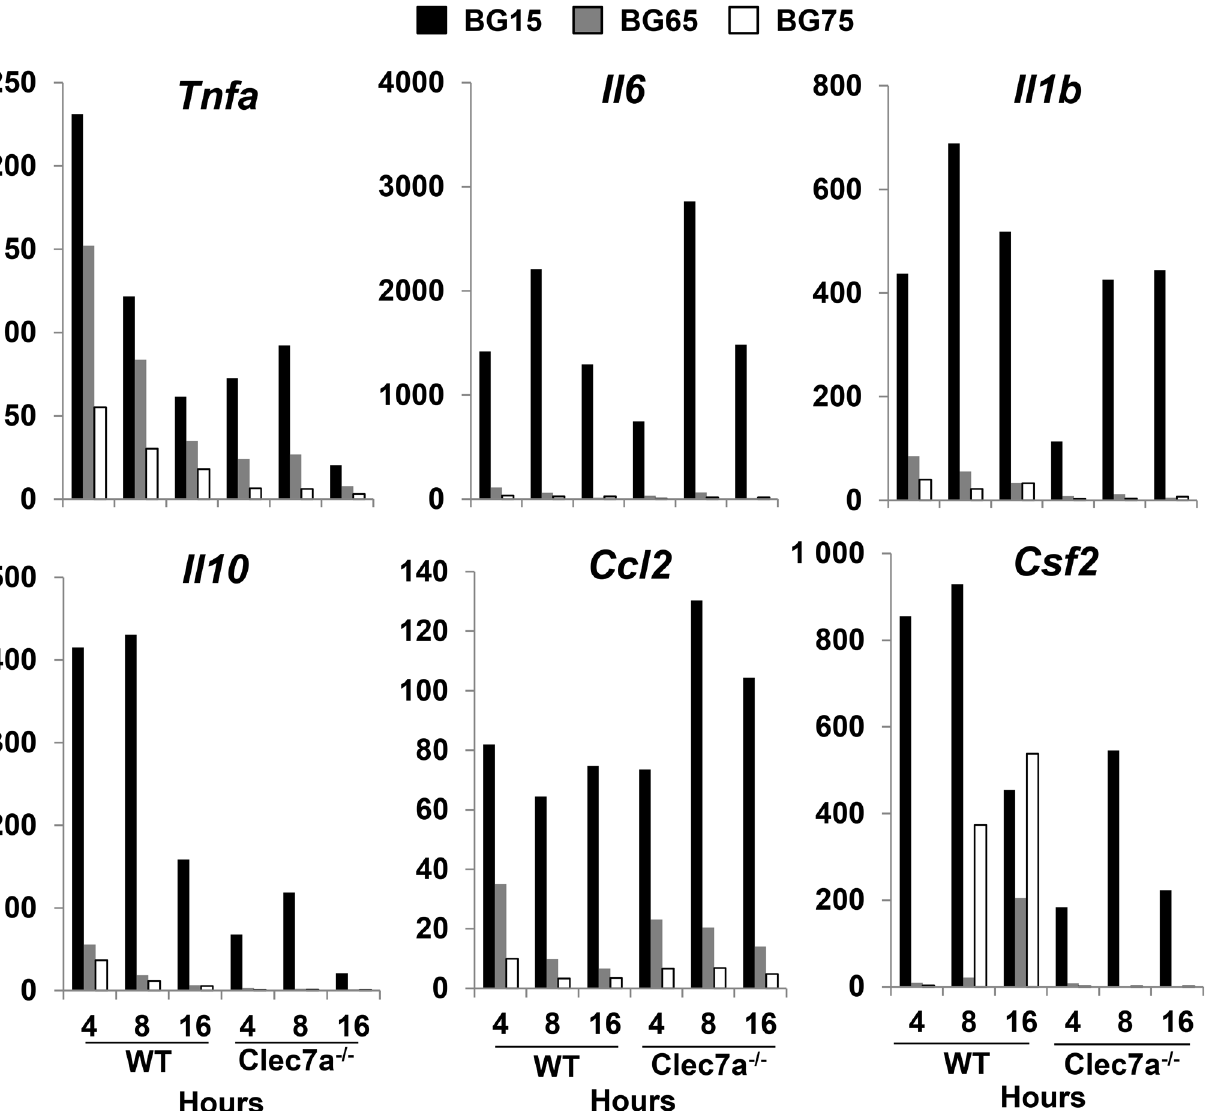
Fig 5. The timing of Clec7a -dependent Csf2 expression depends on Sc BG content. WT and Clec7a (dectin-1) -/- BMDM were stimulated with Sc BG extracts for 4, 8 or 16 h. After incubation, supernatants were removed and cells were lysed in RLT lysis buffer. Total RNA was extracted using the RNeasy Mini Kit and retro-transcribed with the SuperScript III First-Strand Synthesis Super Mix Kit. The expression of cytokine and chemokine genes was measured by quantitative PCR and normalized with three housekeeping genes ( Sdha , Rpl9 and Hprt1 ) selected with GeNorm Software. Individual quantitative PCR was performed on the LightCycler 1 480 system (Roche, Switzerland) using Power SYBR Green PCR Master Mix (Applied Biosystems) to confirm the results obtained with the Biomark method. Data are expressed as fold change related to the mock value, representative of two experiments performed in